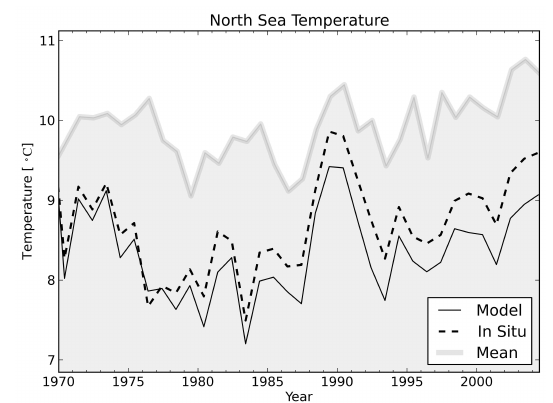
Fig. 12. Annual North Sea temperature time series plot: the black line is the matched model mean annual temperature, the dashed line the annual mean in situ temperature, and and the grey line shows the MLD-averaged mean temperature of the North